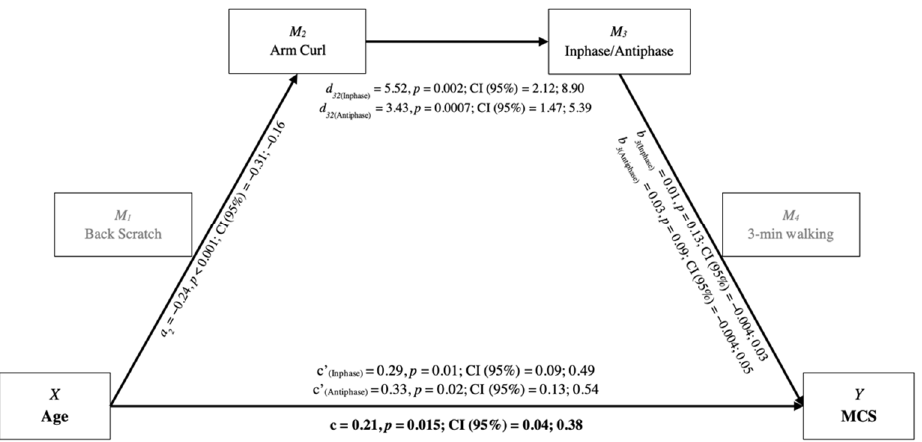
Figure 1. Conceptual and statistical model of age and mediators’ effects on MCS for upper body functional fitness. c’ = direct effect; c = total effect. MCS = Mental Component Summary.